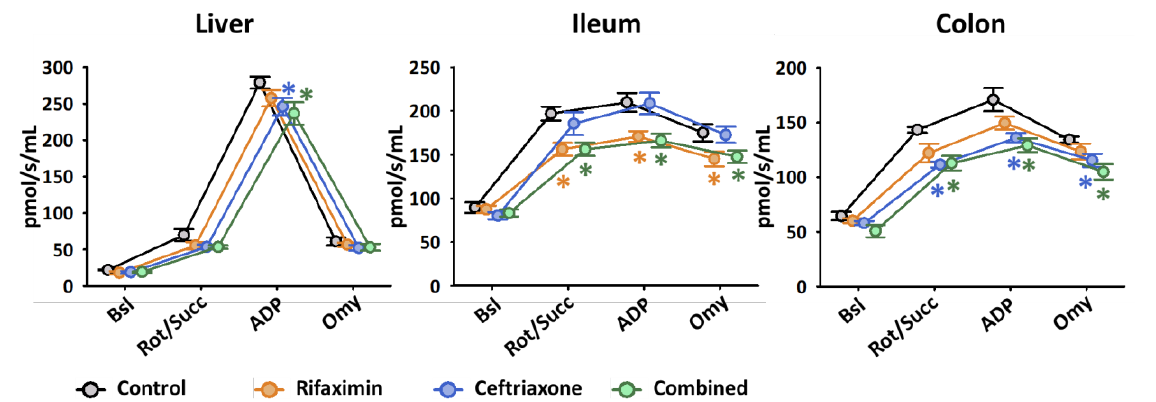
Figure 2. Mitochondrial respiratory function in the liver, terminal ileum and distal colon following systemic antibiotic treatment. After the registration of baseline (Bsl) respiratory activity, state II respiration was measured in the presence of rotenone and succinate (Rot/Succ), OxPhos was measured after the addition of adenosine diphosphate (ADP), and leak respiration in the presence of oligomycin (Omy). Rifaximin group is marked with orange, Ceftriaxone group is marked with blue, combined treatment is marked with green, while control group is marked with grey symbols. Data are presented as mean ± SEM. * p < 0.05 vs. control (one-way ANOVA, Holm – Sidak test) are considered as significant.